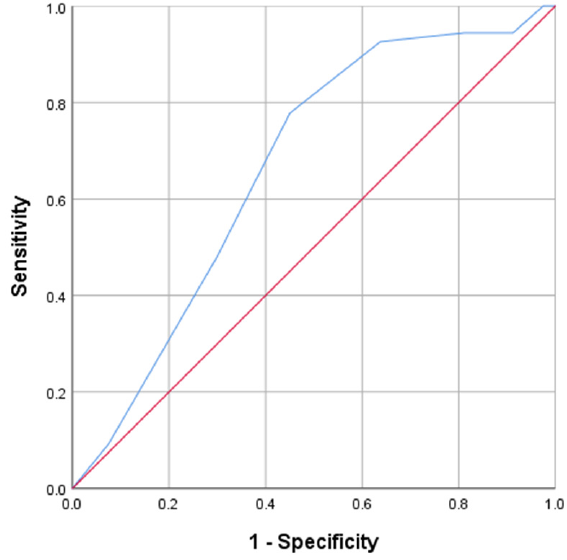
Figure 2. Receiver Operating Characteristic (ROC) curve for the SUNFRAIL tool, using diagnostic criteria for frailty from the Fried phenotype model as a gold standard.